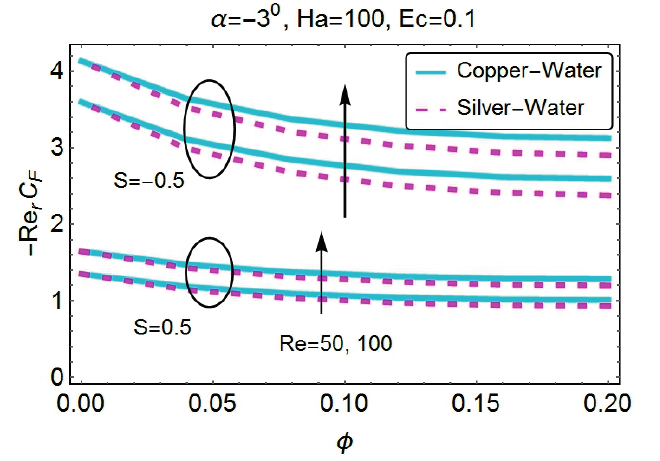
Figure 30. Variation in the skin friction coefficient with the Reynold number and the nanoparticle volume fraction (divergent channel).